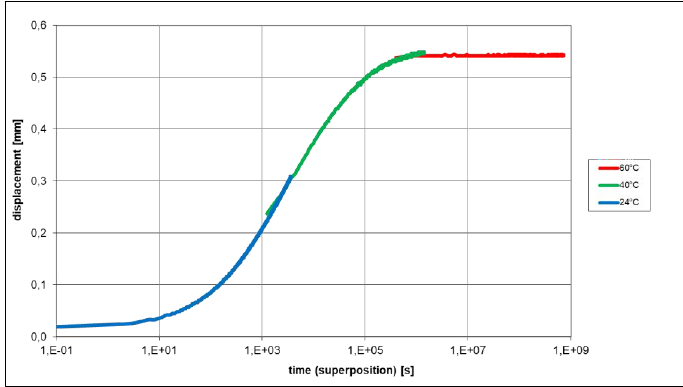
Fig. 17 Time-temperature superposition with E A from the DMTA